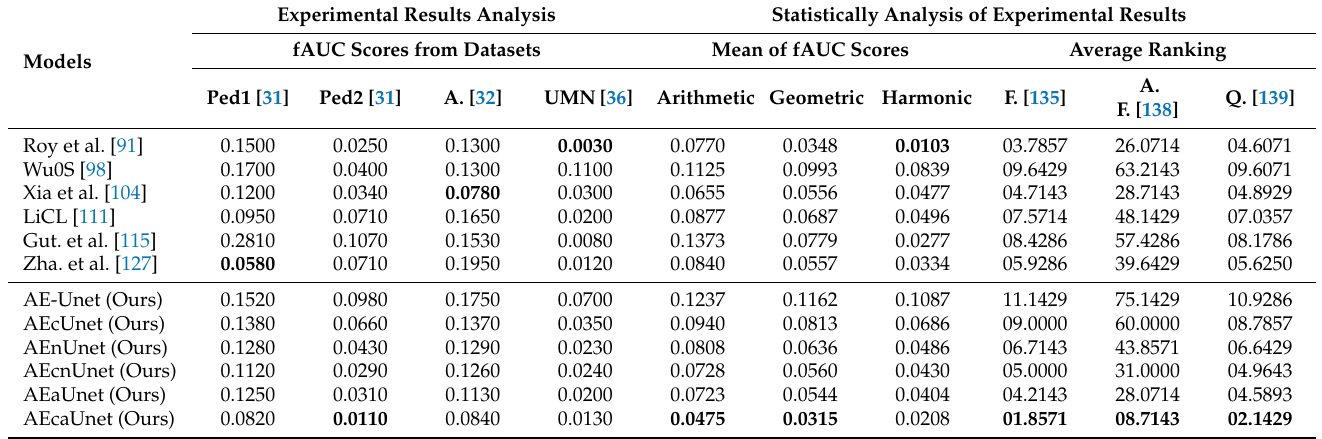
Table 10. Multiple comparison test for G 5 using fAUC. Column-wise the best numerical result is shown in bold